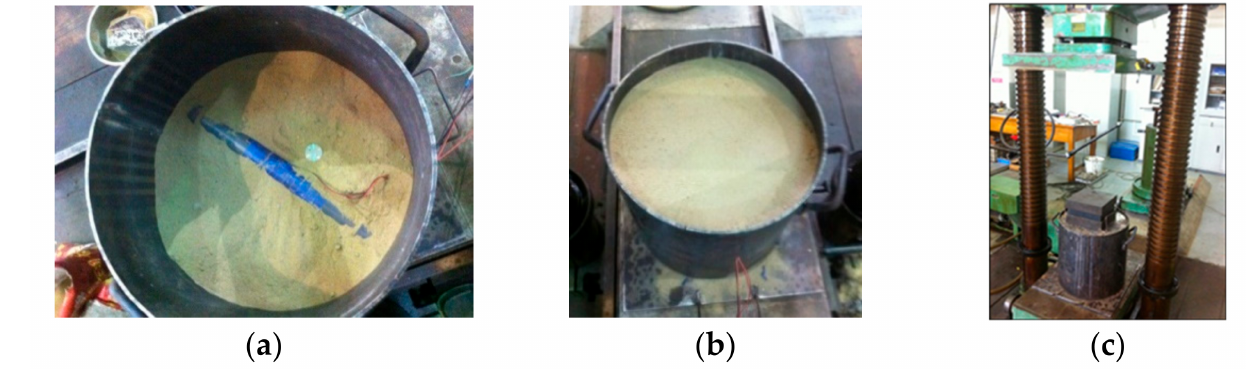
Figure 4. Schematic of experimental preparation and loading process. ( a ) Screen pipe embedding process; ( b ) sand box after burying the screen pipe; ( c ) loading process.